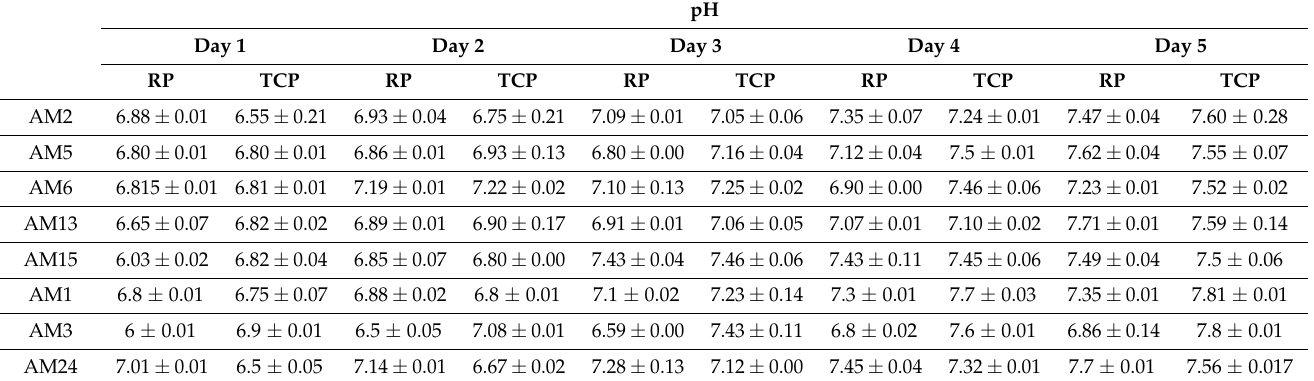
Table 1. Evolution of the pH of the medium of the eight selected actinomycete isolates grown in SMM + TCP and SMM + RP. Standard deviations represent mean values of results from three independent culture